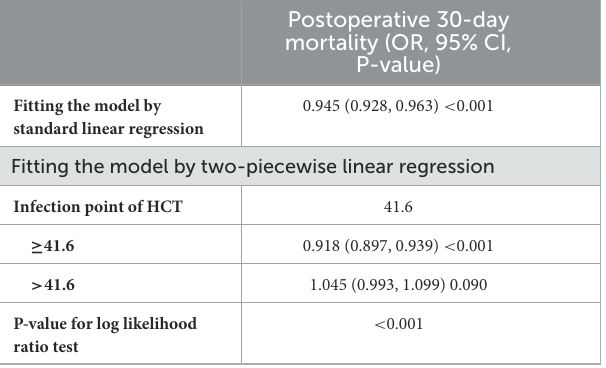
TABLE 3 The results of the two piecewise linear regression models. Postoperative 30-day mortality (OR, 95%